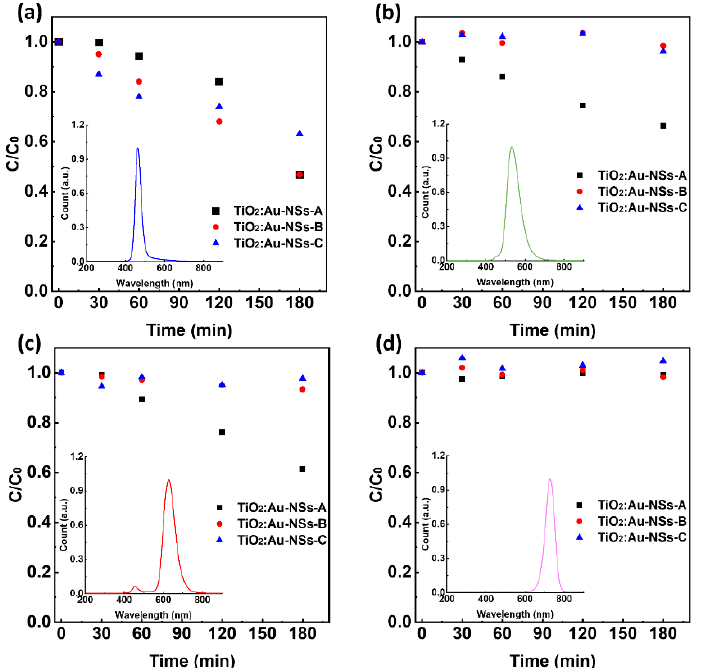
Figure 5. Photocatalytic degradation of CIP (5 mg/L) with TiO 2 :Au-NSs-A, B, and C nanoparticles under 180 min of different wavelengths of light (inset images): blue ( a ), green ( b ), red ( c ), and NIR light ( d ) radiation.